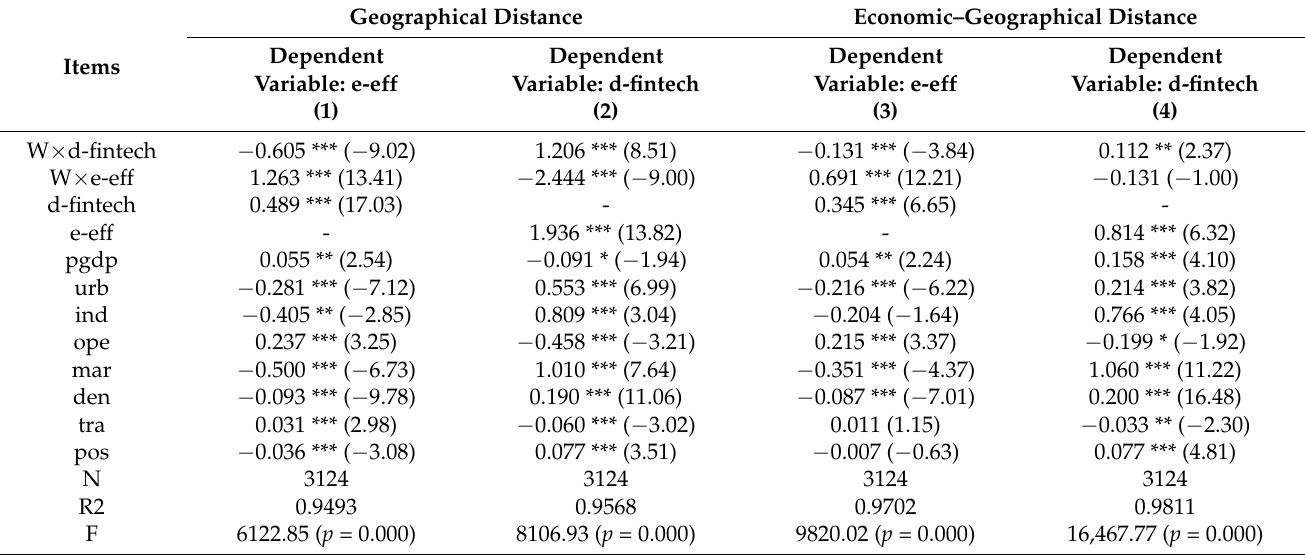
Table 5. Global estimation results of